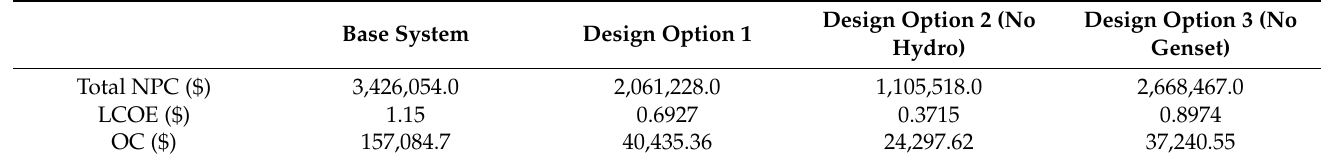
Table 11. Comparison of NPC, LCOE, and Operating Cost